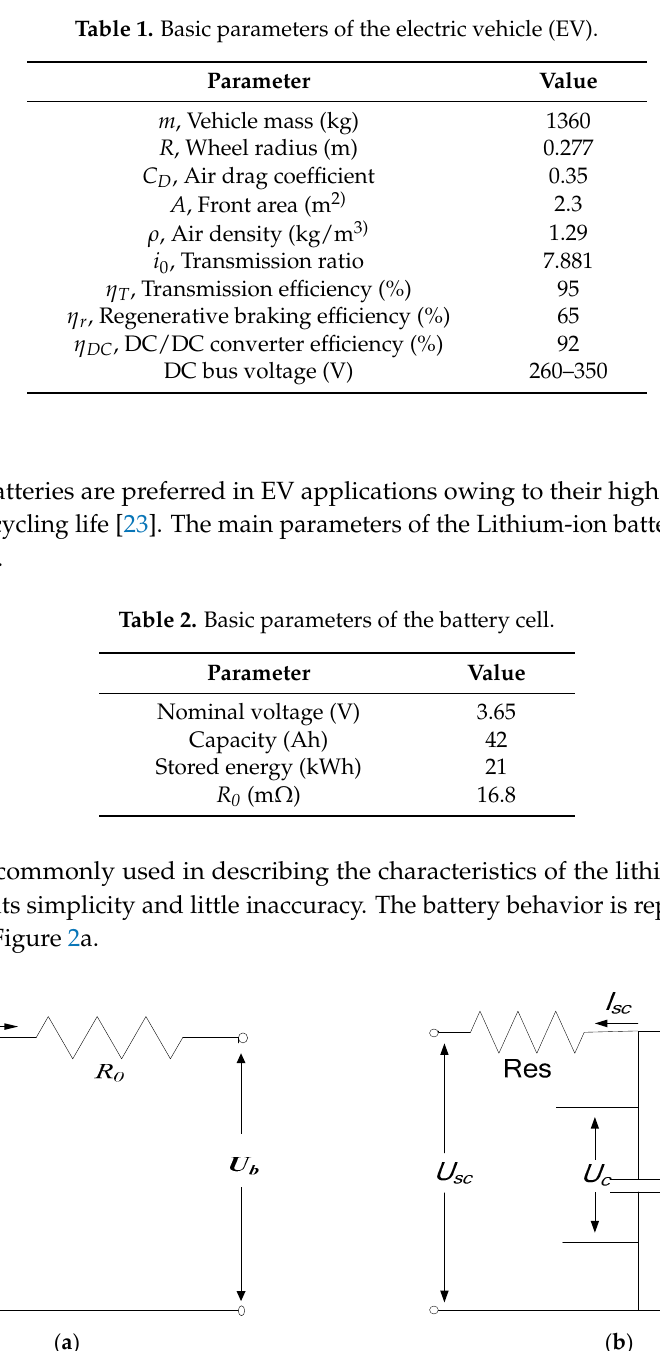
Table 1. Basic parameters of the electric vehicle (EV).